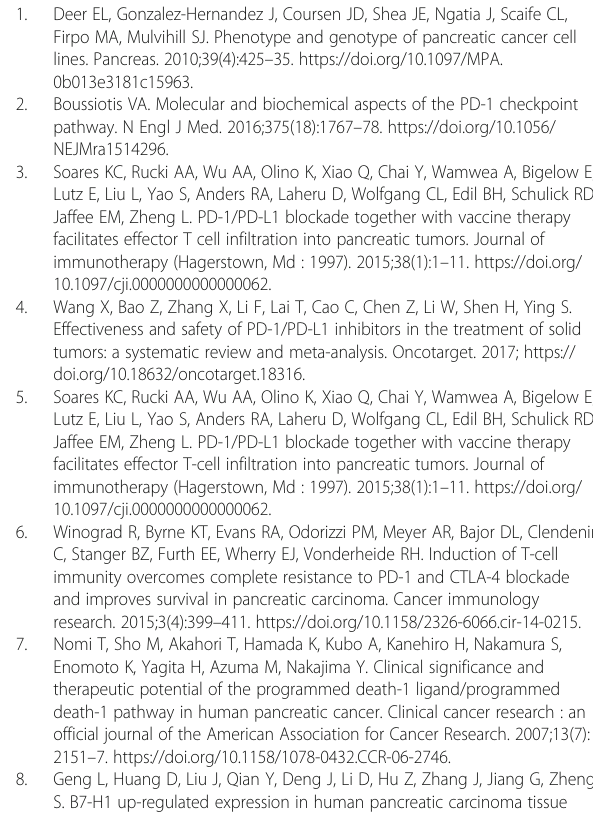
Table S2. PFS and OS stratified by PD-L1 expression using different cut-off points. Table S3. Percentage of tumor cell with PD-L1 membranous staining in the validation set. (DOCX 21 kb) Abbreviations FDA: Food and Drug Administration; FFPE: Formalin-fixed, paraffin- embedded; IHC: Immunohistochemistry; IVD: In vitro diagnostics; OS: Overall survival; PD-1: Programmed cell death protein 1; PDAC: Pancreatic ductal adenocarcinoma; PD-L1: Programmed death-ligand 1; PFS: Progression-free survival; PUMCH: Peking Union Medical College Hospital; TIL: Tumor- infiltrating lymphocyte; TMA: Tissue microarray; WHO: World Health Organization Acknowledgments Not